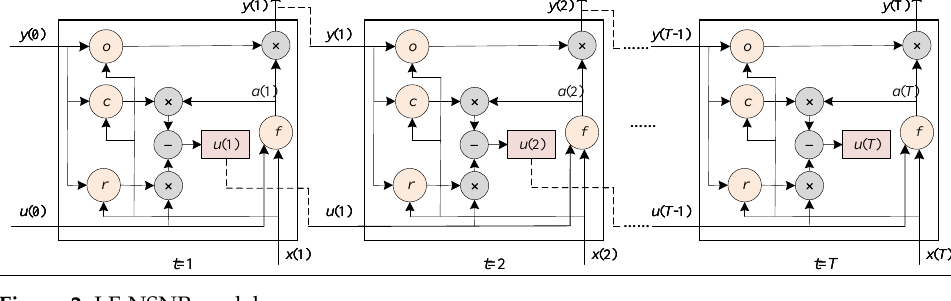
Figure 2. LF-NSNP model.